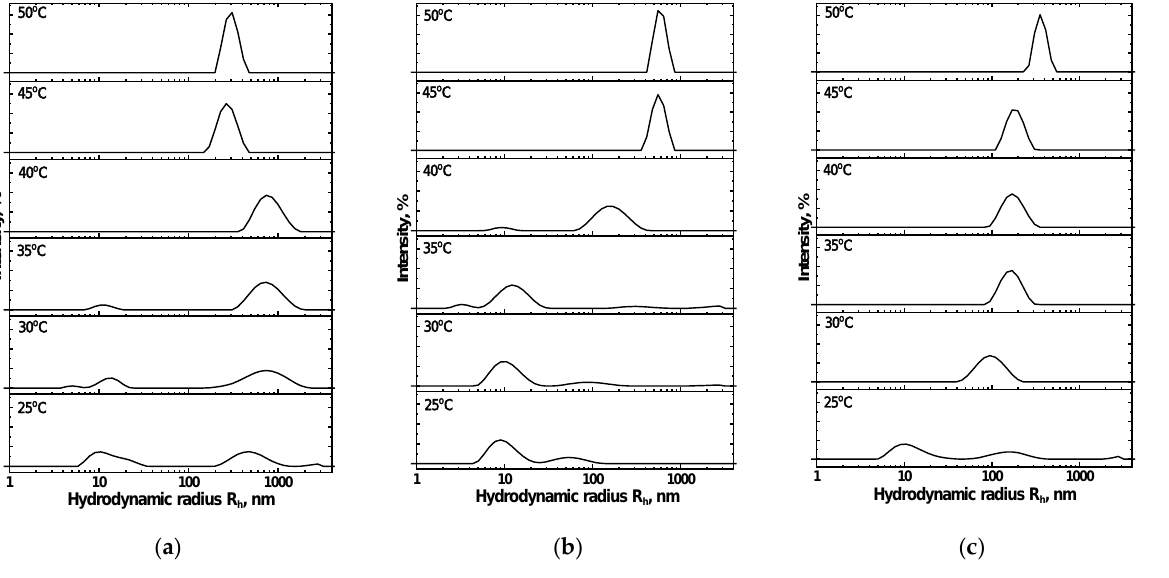
Figure 10. Effect of temperature and ionic strength ( µ ) on the mean hydrodynamic radius (R h ) of NIPAM 90 -APTAC 2.5 -AMPS 7.5 : µ = ( a ) 0.001, ( b ) 0.1 and ( c ) 1.0. AMPS 2.5 .